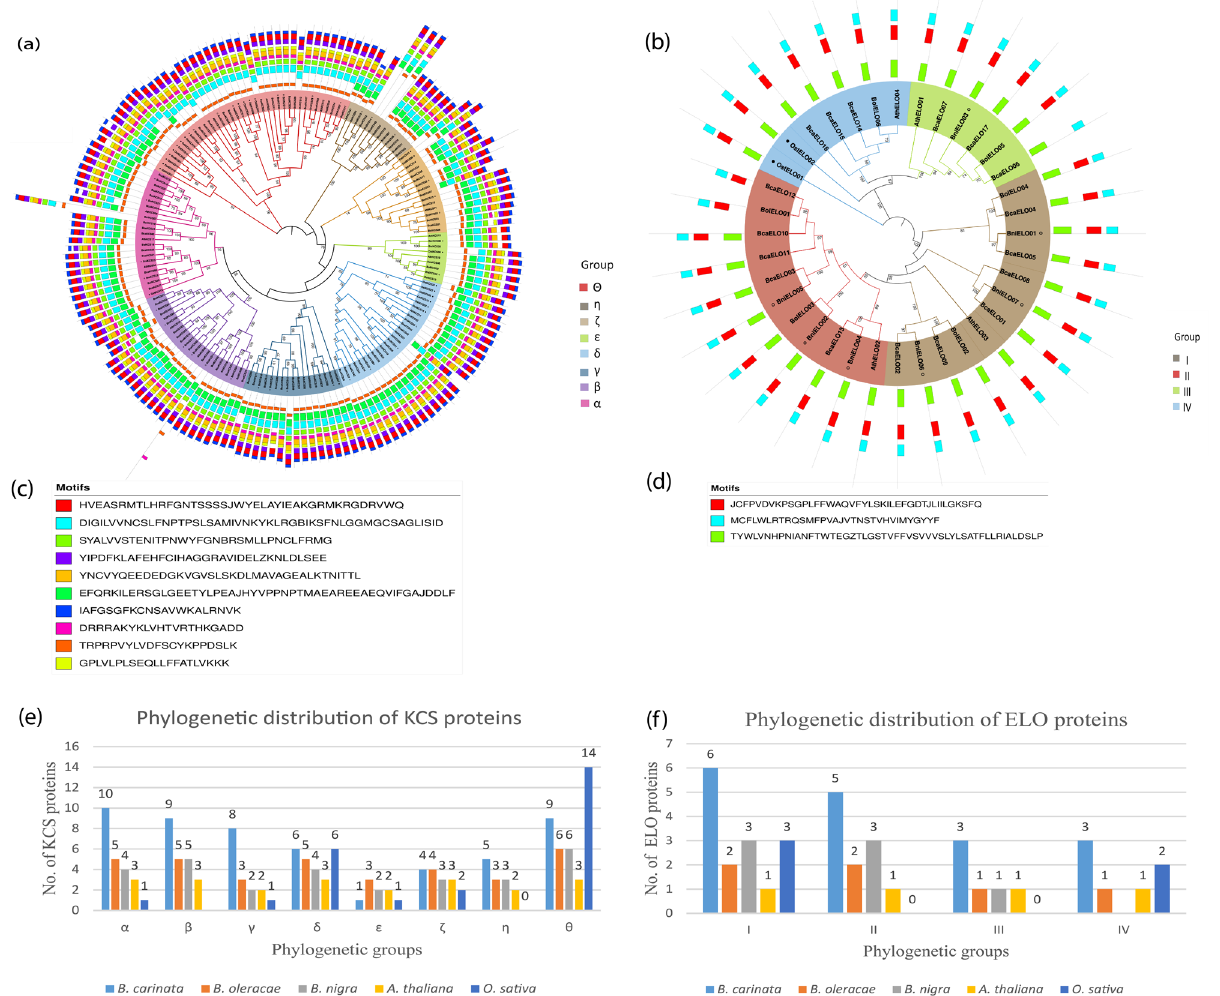
Figure 2. Phylogenetic classification and motifs distribution among KCS and ELO proteins in B. carinata and its progenitors. Phylogenetic grouping of ( a ) KCS-like genes and ( b ) ELO-like genes. Motifs identified among the ( c ) KCS and ( d ) ELO proteins, and group-wise distribution of ( e ) KCS and ( f ) ELO proteins in the B. carinata , its progenitors, Oryza sativa and A. thaliana,